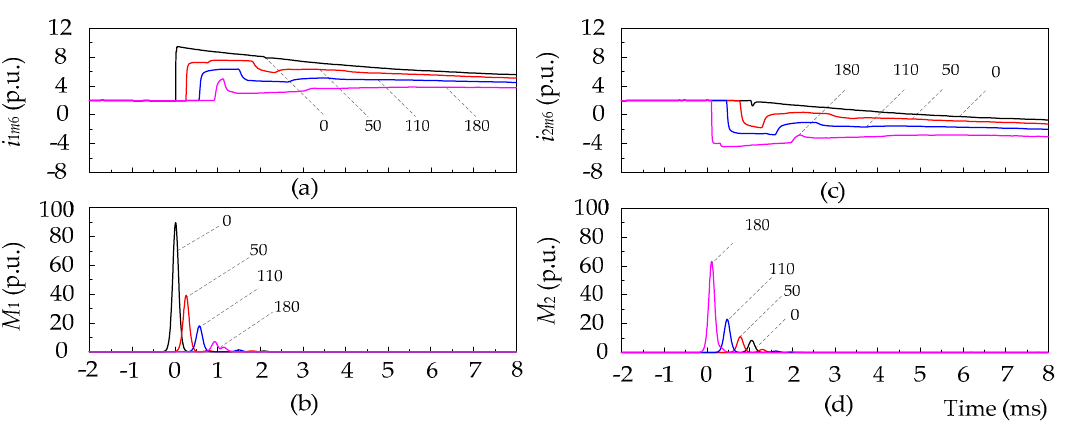
Figure 11. The curves of sixth mode currents and the corresponding M 1 and M 2 during the positive-cable-to-negative-cable (PN) faults with a fault resistance of 100 Ω at various locations. ( a ) Curves of i 1 m 6 . ( b ) Curves of M 1 . ( c ) Curves of i 2 m 6 . ( d ) Curves of M 2 . Table 2. Fault-location results for PN faults with a fault resistance of 100 Ω at different locations. Fault Distance Fault